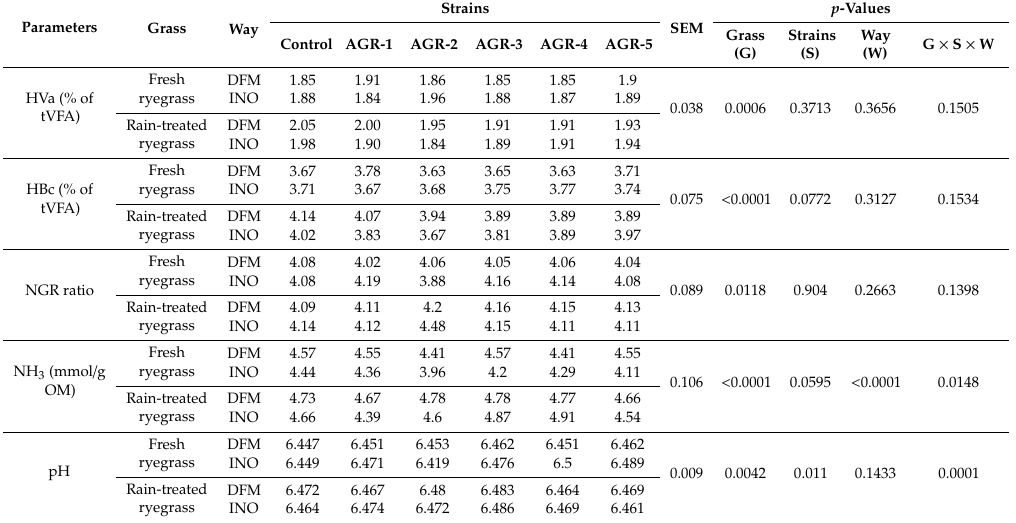
Table 6. E ff ect of LAB strains on fermentation